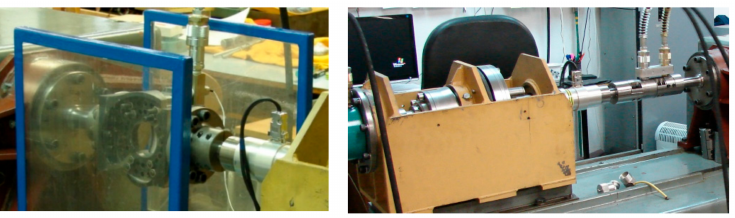
Figure 4. The load case of bending and pressurizing with the pressure chamber and the pressure sensor—FF046 load case (left). The setup of the test case with the pressure chamber inducing inner and outer pressure—FF059 load case (right).